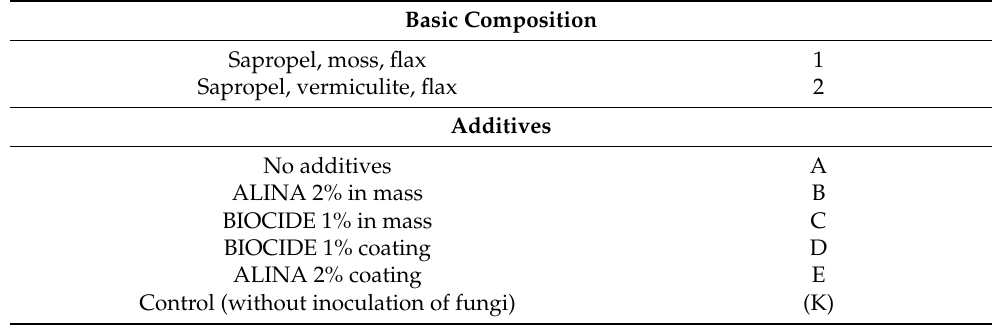
Table 2. Composition, basic composition, and additives of composite materials created in the